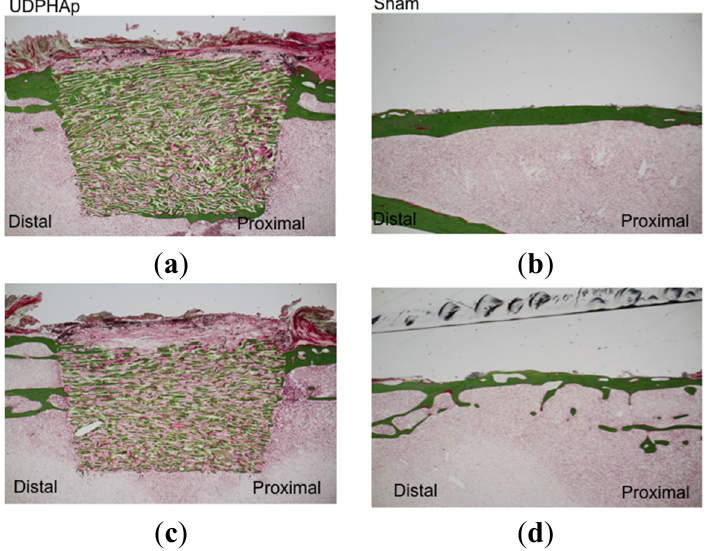
Figure 2. Histological findings of undecalcified sections stained with Villanueva-Goldner